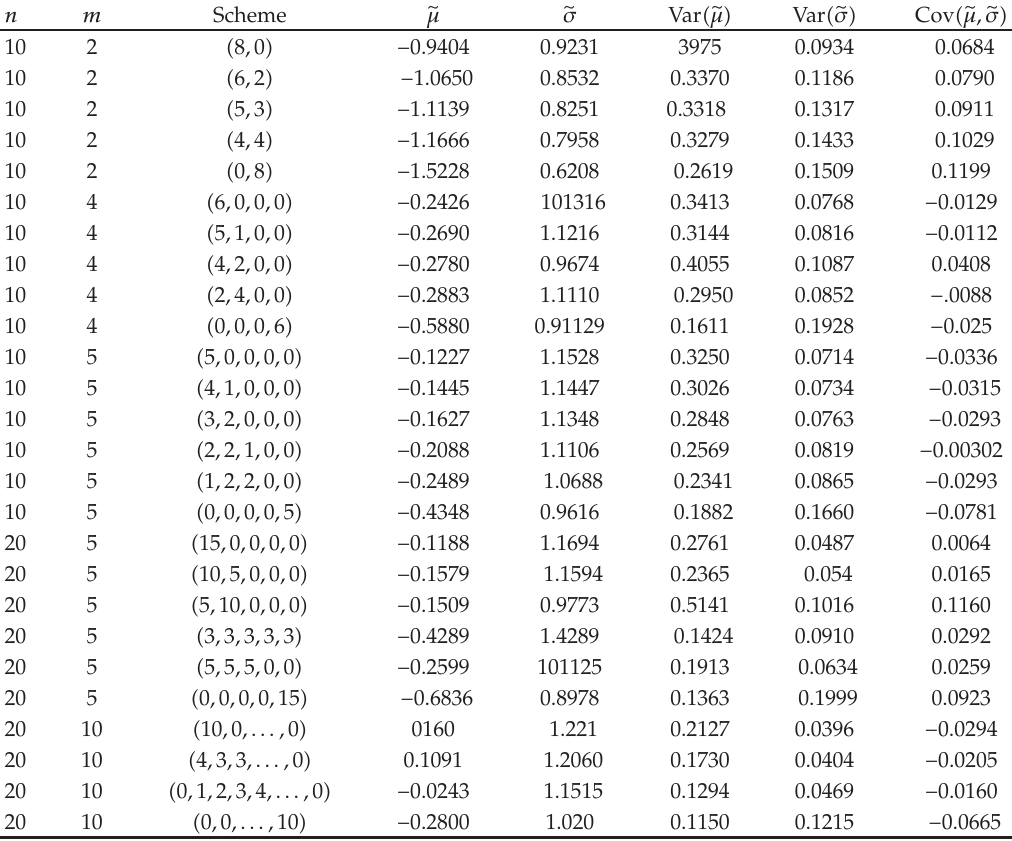
Table 9: Average, variances, and covariance of the approximate MLEs when the shape parameter φ (cid:7) 3.